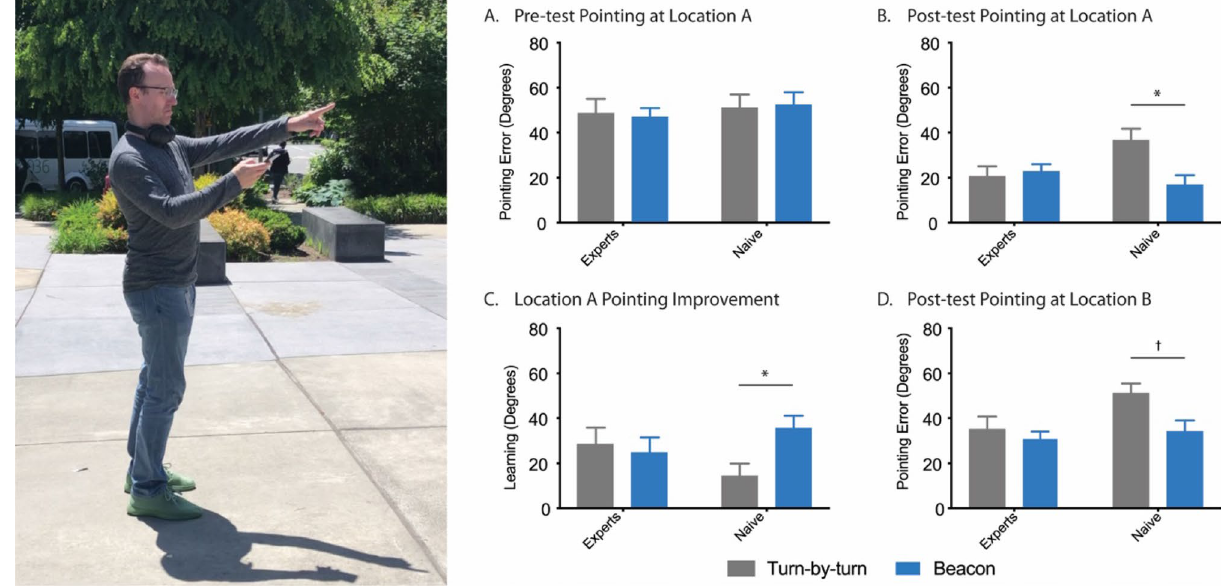
Figure 3. Performance of all groups and conditions on the pre-test and post-test pointing tasks. ( A ) Pointing error of all groups and conditions from Location A at pre-test. ( B ) Pointing error of all groups and conditions from Location A at post-test. ( C ) Improvement of all groups and conditions when pointing from Location A (pre-test minus post-test pointing error). ( D ) Pointing error of all groups and conditions from novel Location B at post-test. All data are presented as ± SEM, * p < 0.05, † p <